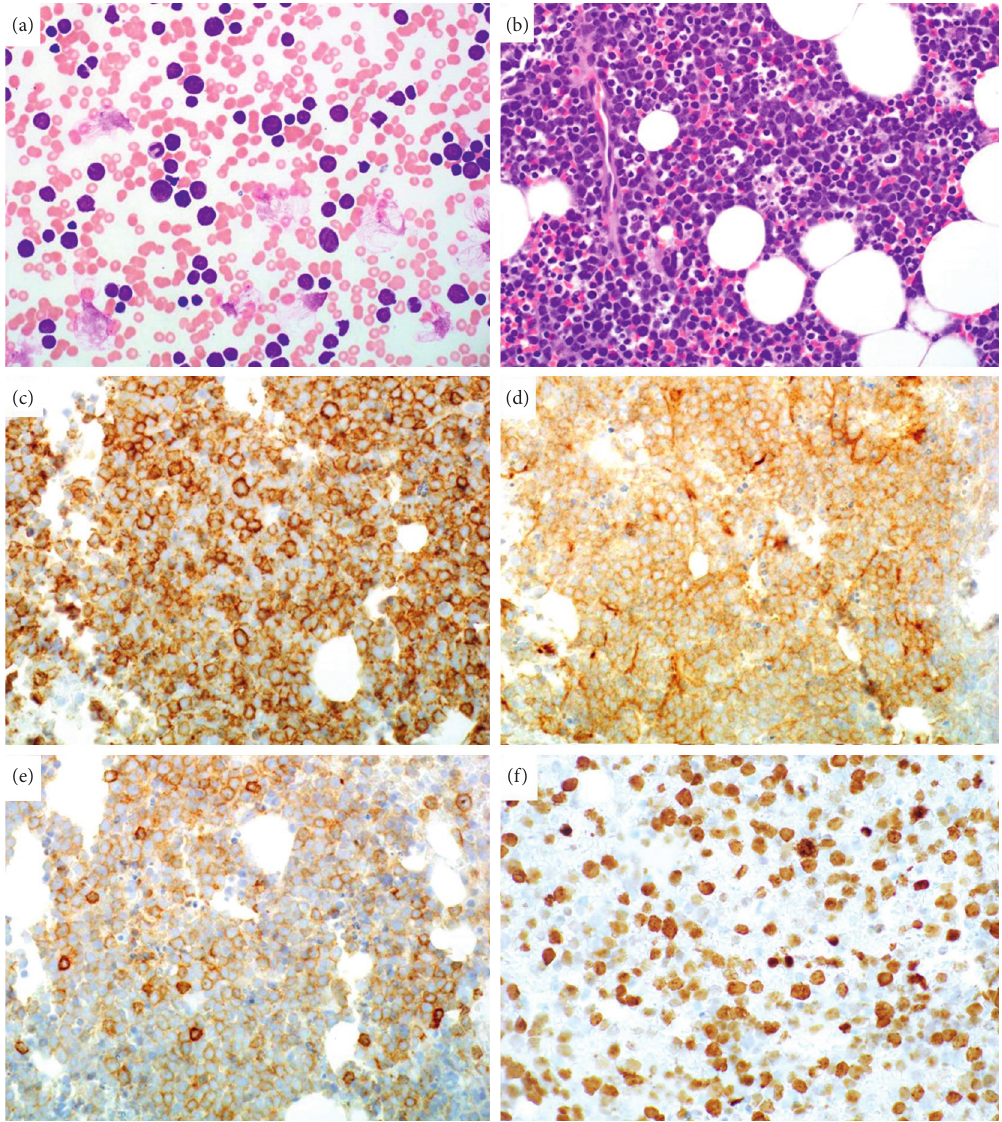
Figure 1: The patient’s peripheral blood features medium and large-sized cells with scant cytoplasm and irregular nuclear contours (a; 400x magnification). Approximately 70–80% of the cellular elements within his hypercellular bone marrow biopsy show morphologic char- acteristics similar to those seen in the peripheral blood (b; 400x magnification). The cells are positive for CD20 (c), CD10 (d), and CD5 (e) by immunohistochemistry (400x magnification). Ki-67 demonstrates a high proliferation index of 80% (f; 400x